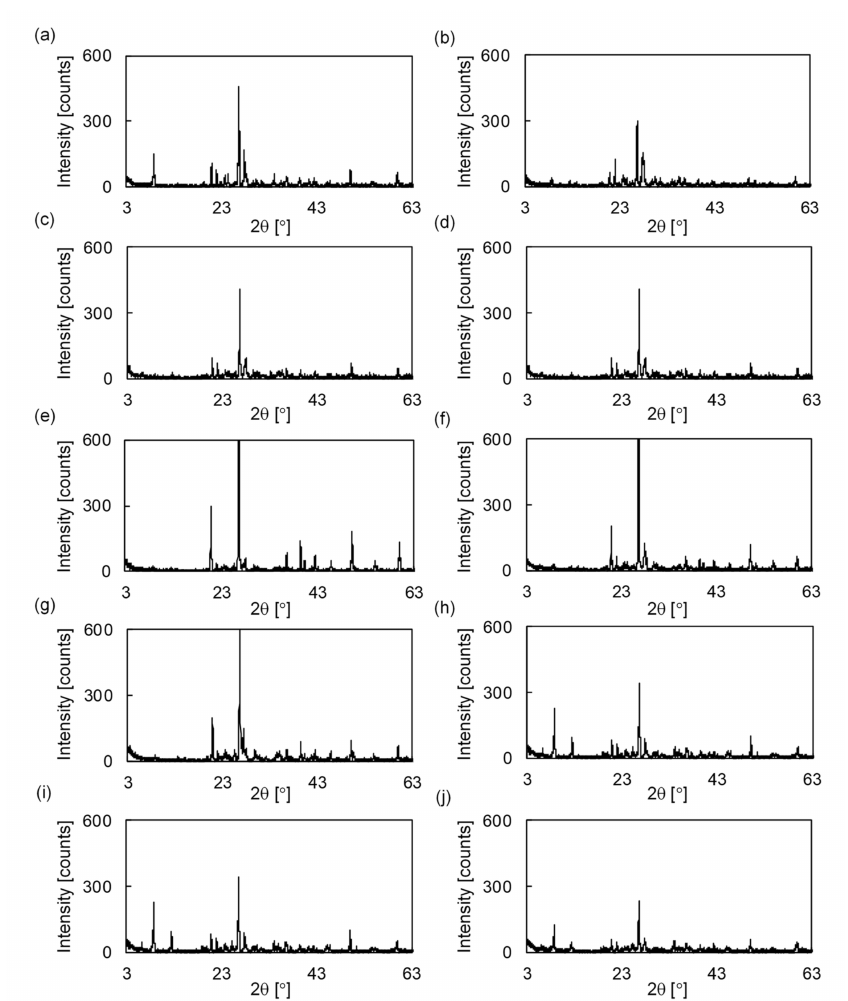
Figure 4. Results of X-ray di ff raction for samples ( a ) albite 1, ( b ) albite 2, ( c ) albite 3, ( d ) albite 4, ( e ) quartz 1, ( f ) quartz 2, ( g ) quartz 3, ( h ) biotite, ( i ) calcite, and ( j )